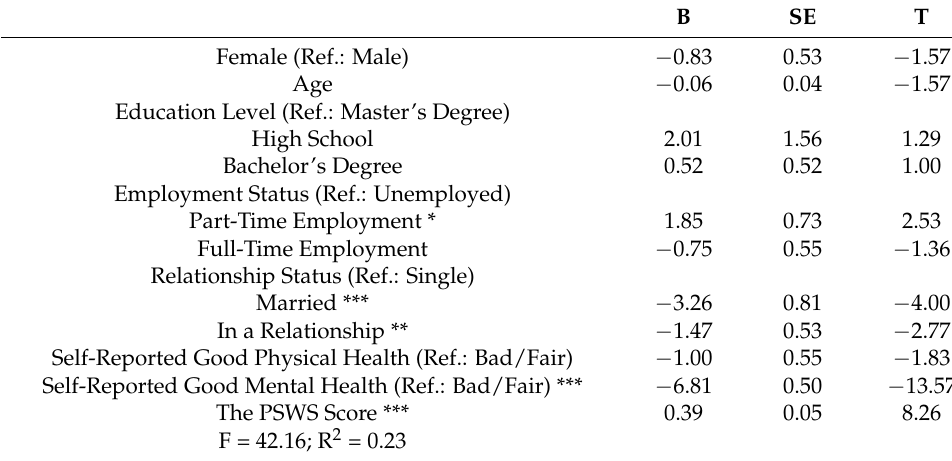
Table 3. Pearson correlations between the PSWS score and scores on the mental health scales. PSWS Score Pearson r p -Value The CES-D Score 0.23 <0.001 The SIAS-C Score 0.22 <0.001 The UCLA Loneliness Scale Score 0.22 <0.001 After adjustments for sociodemographic characteristics and self-reported health sta- tuses, multiple regression analysis revealed that the problematic binge-watching score was significantly associated with the scores for depression, social interaction anxiety, and loneliness ( β = 0.39, 0.55, and 0.35, respectively; all p < 0.001; Tables 4–6, respectively). Table 4. Multiple regression model of depression, measured on the Center for Epidemiologic Depression Scale (CES-D). B